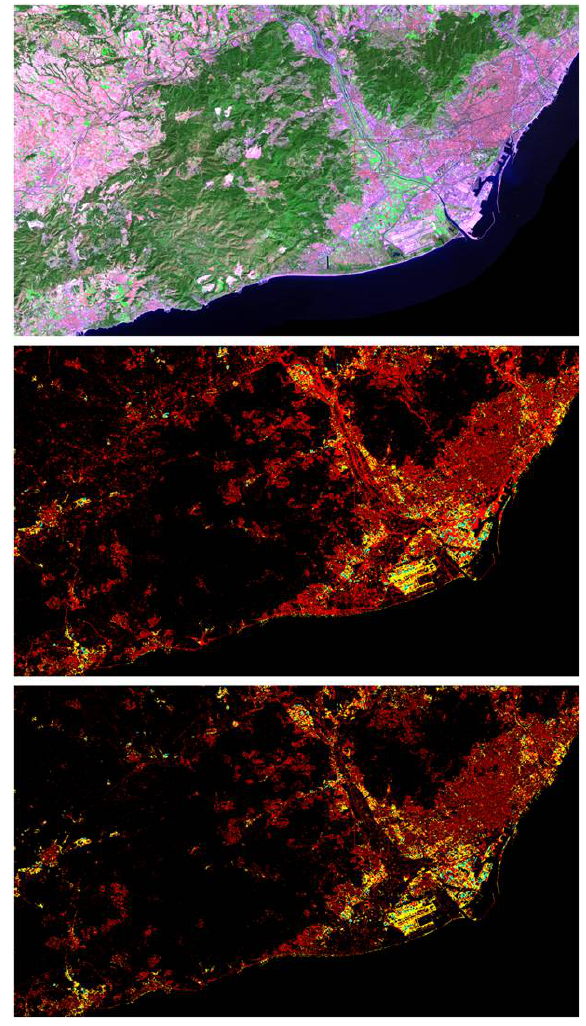
Figure 6. Landsat image; an example of result of Minimum Distance classification, and final result after